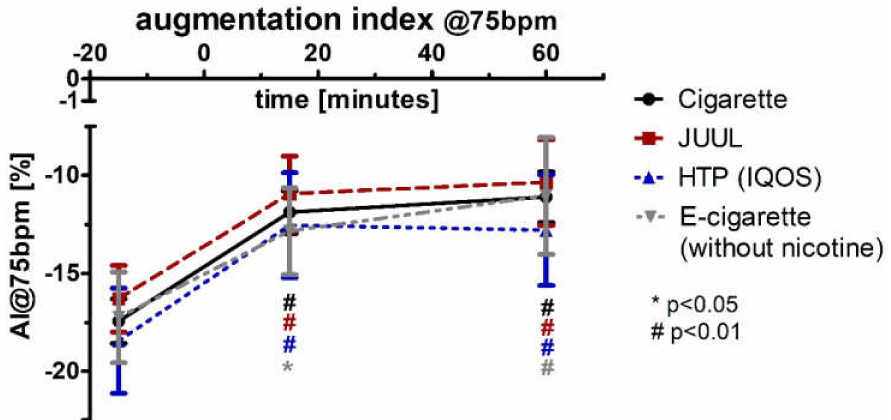
Figure 9. Augmentation index adjusted at a heart rate of 75 bpm before and 15 as well as 60 min after consuming the cigarette, JUUL TM , heated tobacco product, and e-cigarette without nicotine.